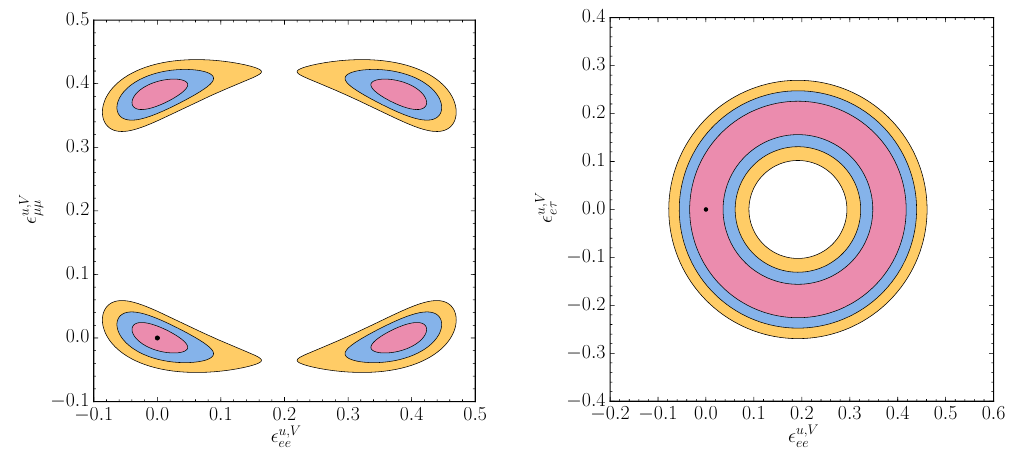
Figure 5 . The projected COHERENT sensitivity to NC vector-like NSI parameters. The left (right) panel shows the expected con(cid:12)dence regions projected onto the (cid:15) u;V plane, after setting the remaining NSI parameters to zero. In both cases, the pink, blue and yellow regions indicate the allowed regions at 1 (cid:27) , 2 (cid:27) and 3 (cid:27) (for 2 d.o.f.). The black dots indicate the SM, which has been used to generate the simulated experimental data used in this (cid:12)gure. The experiment has been simulated using 10 kg